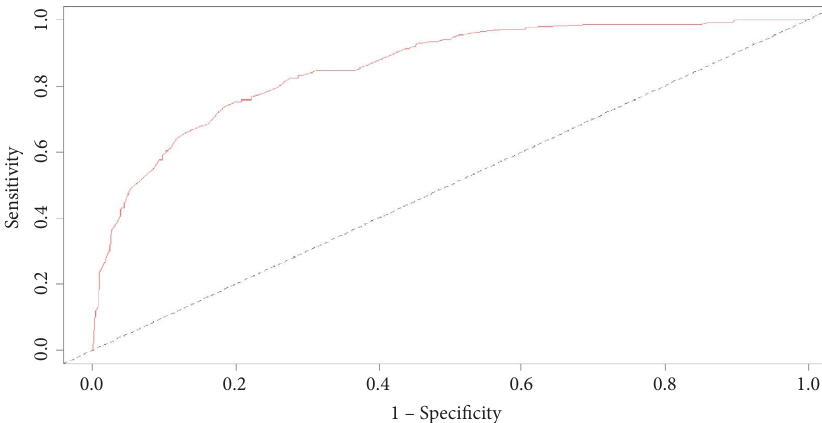
Figure 2: ROC curve of the prediction model in the modeling